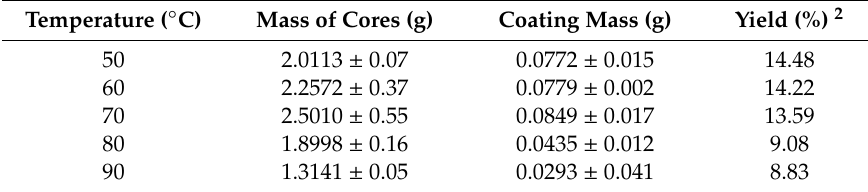
Table 4. Yield of aerosol coating process at di ff erent temperatures 1